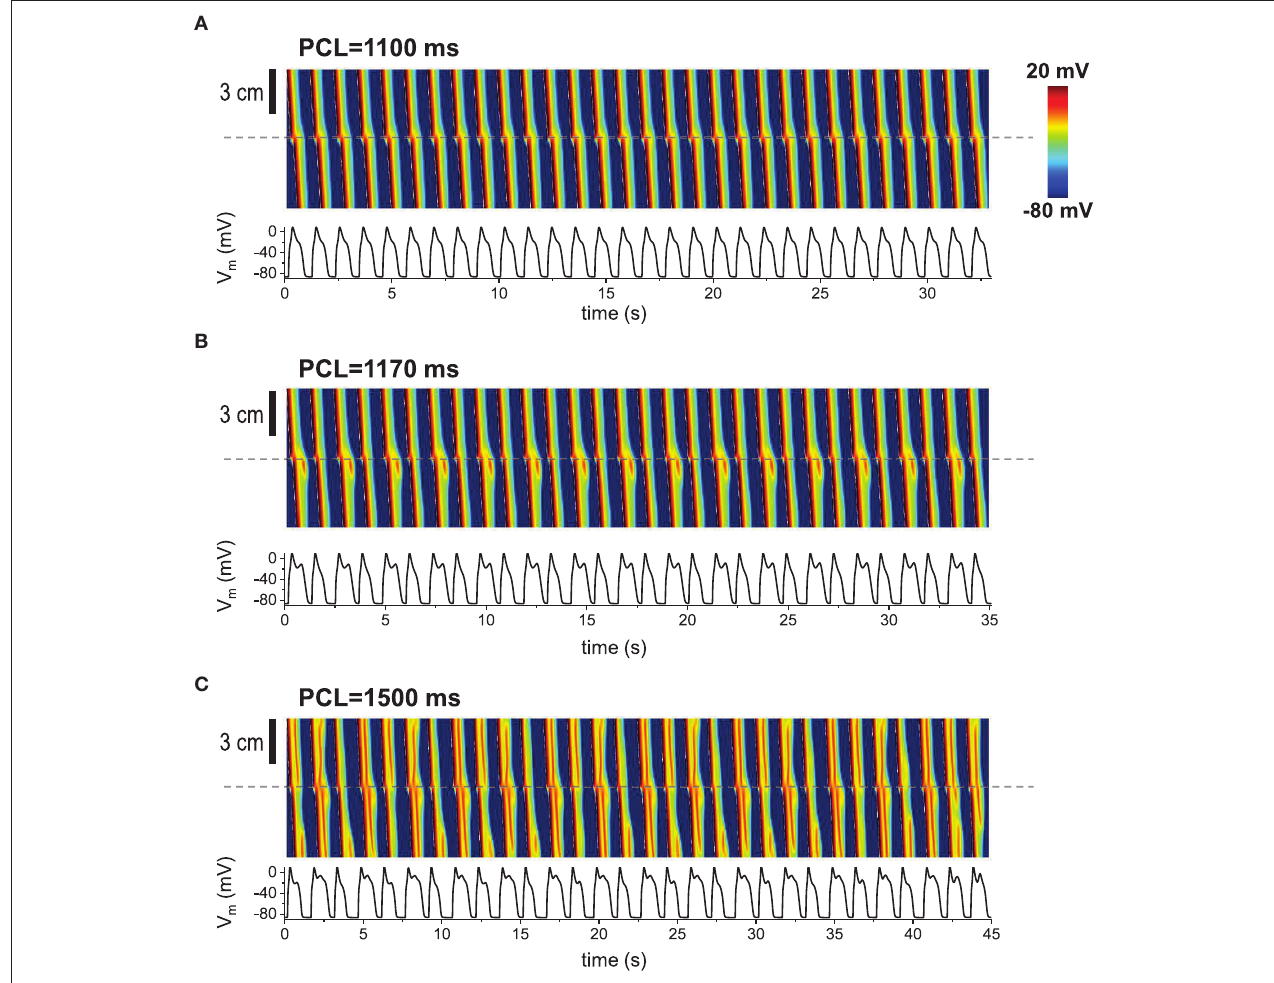
FIGURE 3 | Repetitive pacing When 1D cable was paced repetitively, various patterns appeared. Top: Space-time plot. The AP traces (bottom) were taken at the middle of the cable (indicated by dashed lines). The gap size is 1.5mm. The tissue was paced 200 times. Last 30 beats are shown here. (A) Periodic (period-1) pattern. No EADs at the gap region. (B) Period-2. EADs occur every other beat. (C) Complex pattern. Spatiotemporal